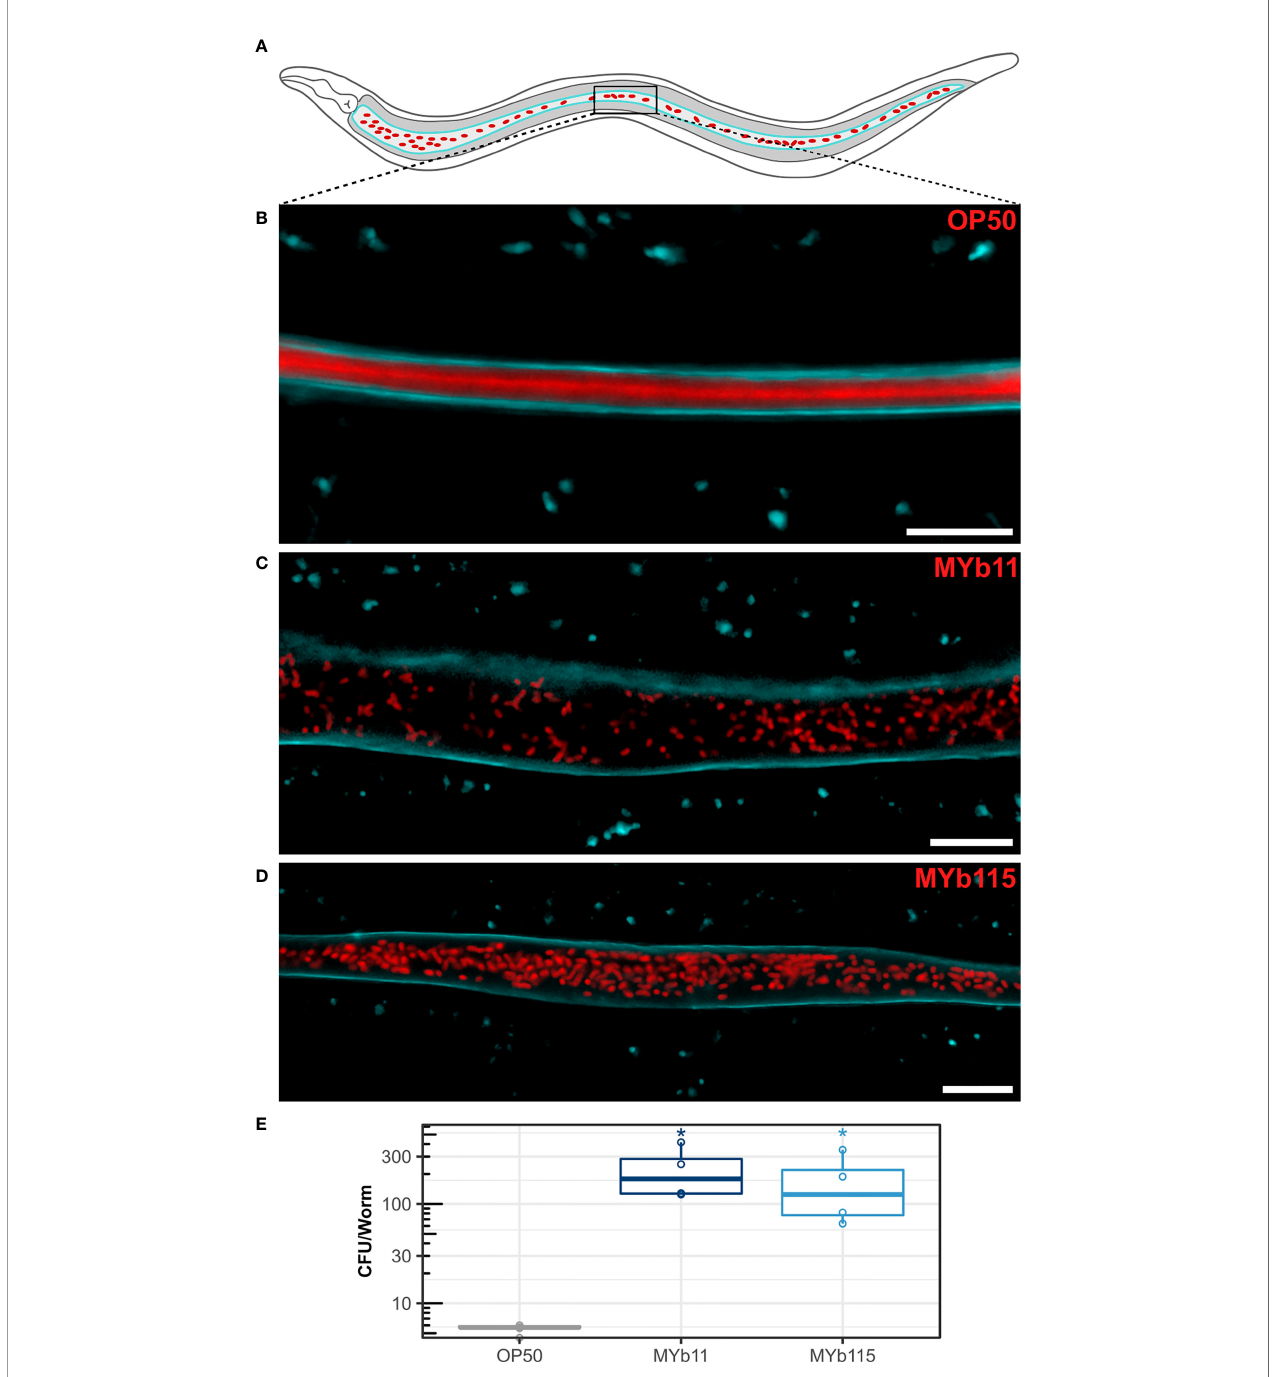
FIGURE 2 | Colonization of the C. elegans intestine by MYb11 and MYb115. (A) Schematic overview of C. elegans intestinal cells (grey) expressing CFP-tagged IFB-2 (cyan) at the apical domain and accumulation of dTomato-tagged bacteria (red) in the intestinal lumen. The box indicates the central area of the intestine where the confocal laser scanning micrographs shown in (B – D) were created. All worms used for microscopy (B – D) and CFU (E) assays were young adult worms (24h post L4 stage). (B – D) Confocal laser scanning micrographs showing optical longitudinal sections through intestinal structures of young adults of the transgenic C. elegans strain BJ49 kcls6 (IFB-2::CFP) that had been exposed to fl uorescently tagged (B) E . coli OP50, (C) P. lurida MYb11, or (D) P. fl uorescens MYb115. The dTomato fl uorescence of the bacteria is shown in red, and the CFP fl uorescence at the apical domain of the intestine is shown in cyan. Scale bars = 10 µm. (E) Bacterial load was measured in colony-forming units (CFUs) per worm (n=4 biological replicates), and compared to the CFU of OP50 control P values are considered signi fi cant and denoted with asterisks according to * p < 0.05, as determined by Wilcoxon-Rank Sum analysis with FDR correction. Also see Supplementary Figure S2 and Supplementary Table